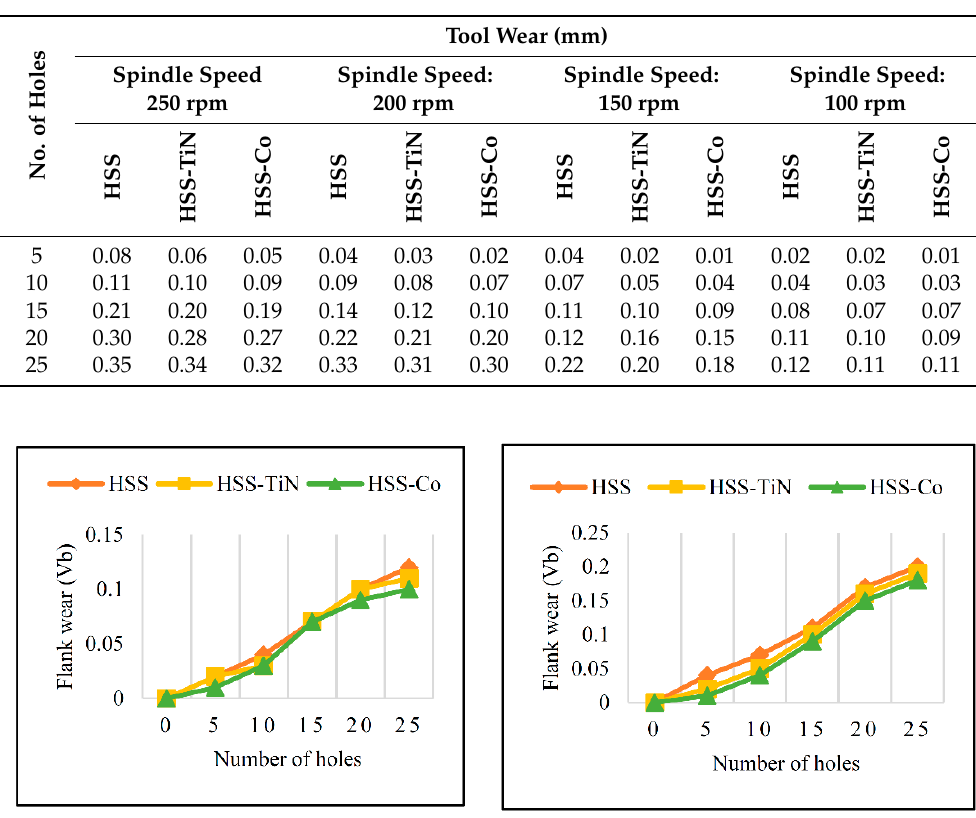
Table 3. Tool wear effects on different spindle speeds using HSS, HSS-TiN, and HSS-Co.